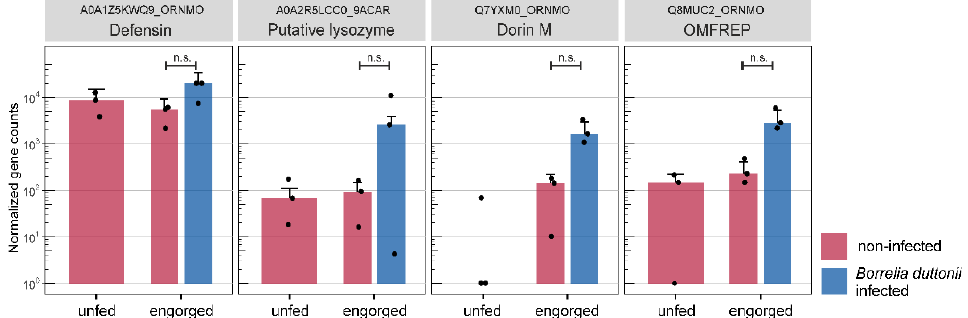
Figure 5. Immune related transcripts. Boxplots show the normalized gene counts of transcripts that have been related to tick immune response. The different sample groups are highlighted by color: unfed (red), engorged (red) and Borrelia duttonii -infected (blue). Error bars represent the standard deviation and dots represent individual samples; ns: not significant.